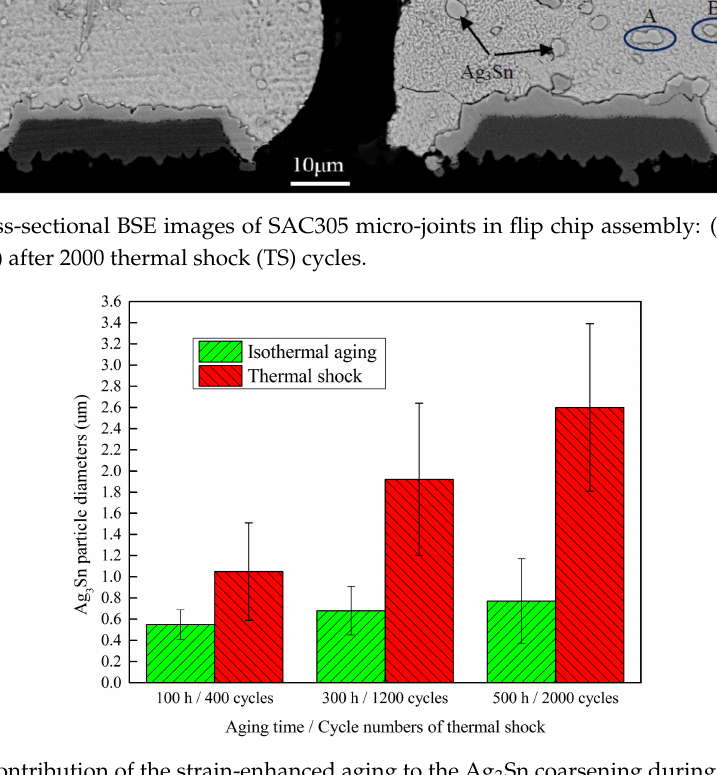
Figure 4. Contribution of the strain-enhanced aging to the Ag 3 Sn coarsening during TS